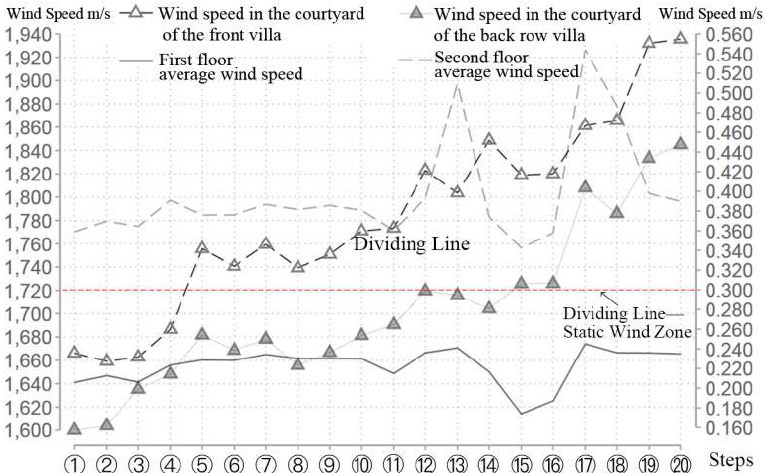
Figure 15. The average outdoor wind speed and the average wind speed in the courtyard of the front and rear buildings at different optimization stages.